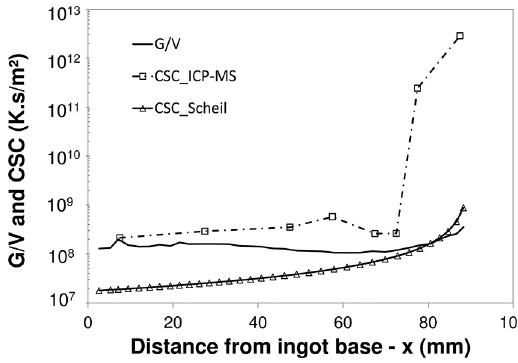
Figure 8. Calculations of G/V and of the CSC parameter for measured concentrations (ICP-MS) and Scheil model concentrations (CSC-Scheil) as a function of the distance from the ingot base